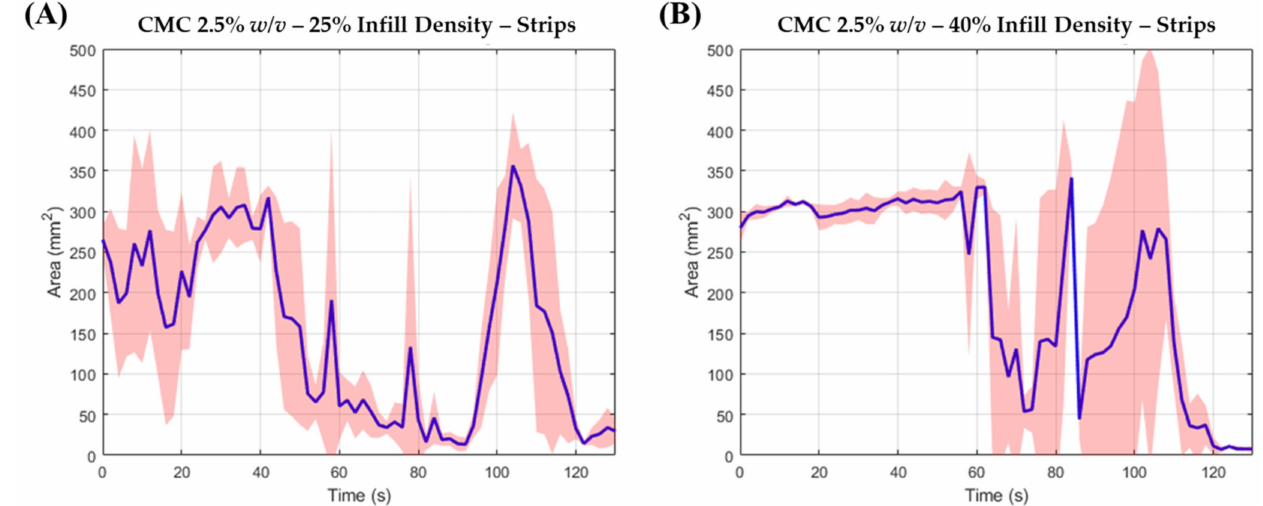
Figure 4. Mean top-down area-time profiles for ( A ) 25% and ( B ) 40% ID strip assessed in the OCM ( n = 3).